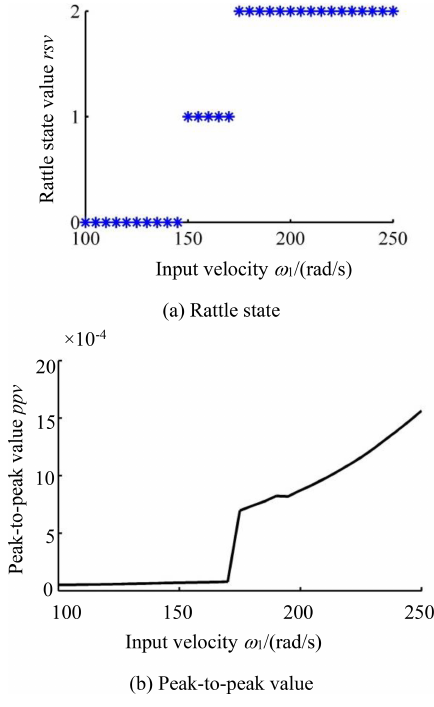
Figure 11. Change in vibration with input